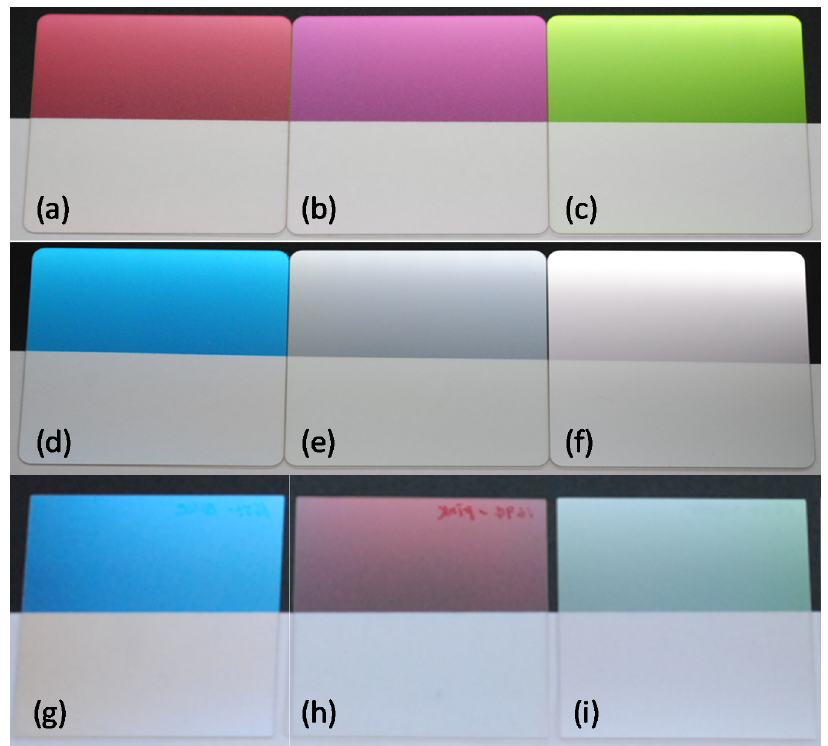
Figure 1. Optical images of experimental glass samples having wavelength-selective hard coatings. Samples are arranged with a black background underneath the top half of each sample and a white background under the bottom half of each sample. Vivid colors are visible in reflectance against a black background, while transmitted light viewed against the white background has relatively more neutral colors in these designs. Samples ( a – e ) represent coating Design Strategy 1, where the wavelength-selective interference layers are located above the thickest hard coating layer; samples ( f – i ) represent Design Strategy 2, where the wavelength-selective layers are “buried” below this hard coat layer. Samples are named as ( a ) WSC-Red-1, ( b ) WSC-Pink-1, ( c ) WSC-Green-1, ( d ) WSC-Blue-1, ( e ) WSC-Silver-1, ( f ) WSC-Silver-2-B, ( g ) WSC-Blue-2-B, ( h ) WSC-Pink-2-B, and ( i ) WSC-Silver-3-B.